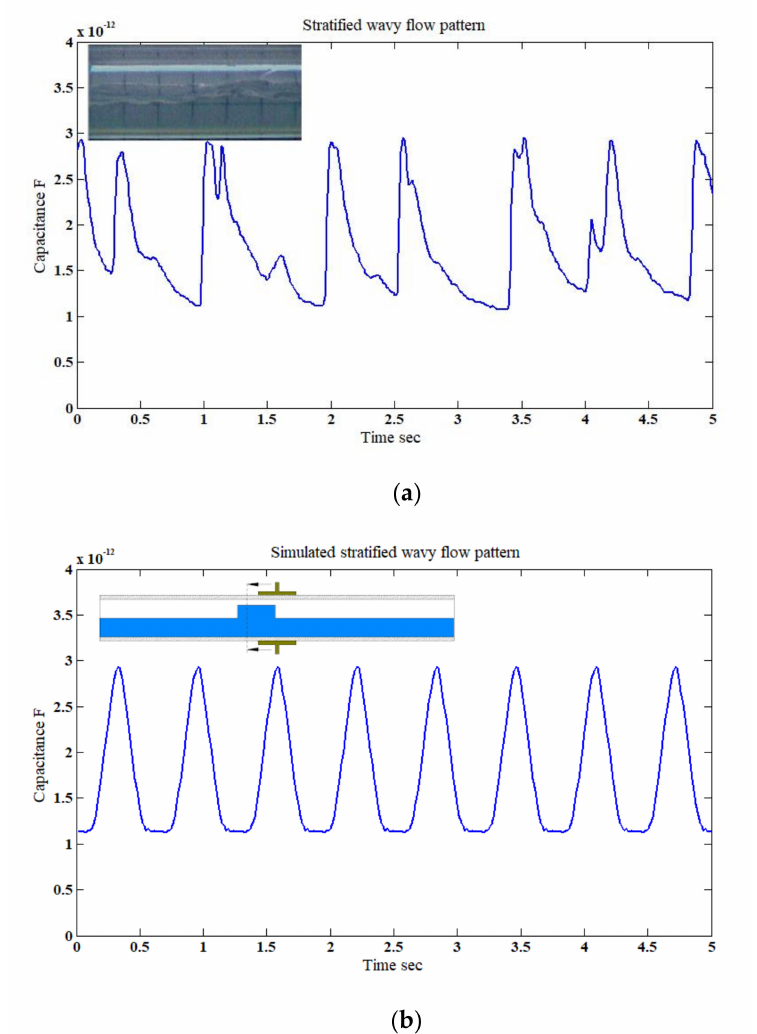
Figure 12. The time-dependent fluctuation of the capacitance value for the stratified flow pattern: ( a ) experimental [32], and ( b ) simulation (for the superficial gas–liquid phase velocities of 3 m / s and 0.318 m / s, respectively; inclination angle β = 0 ◦